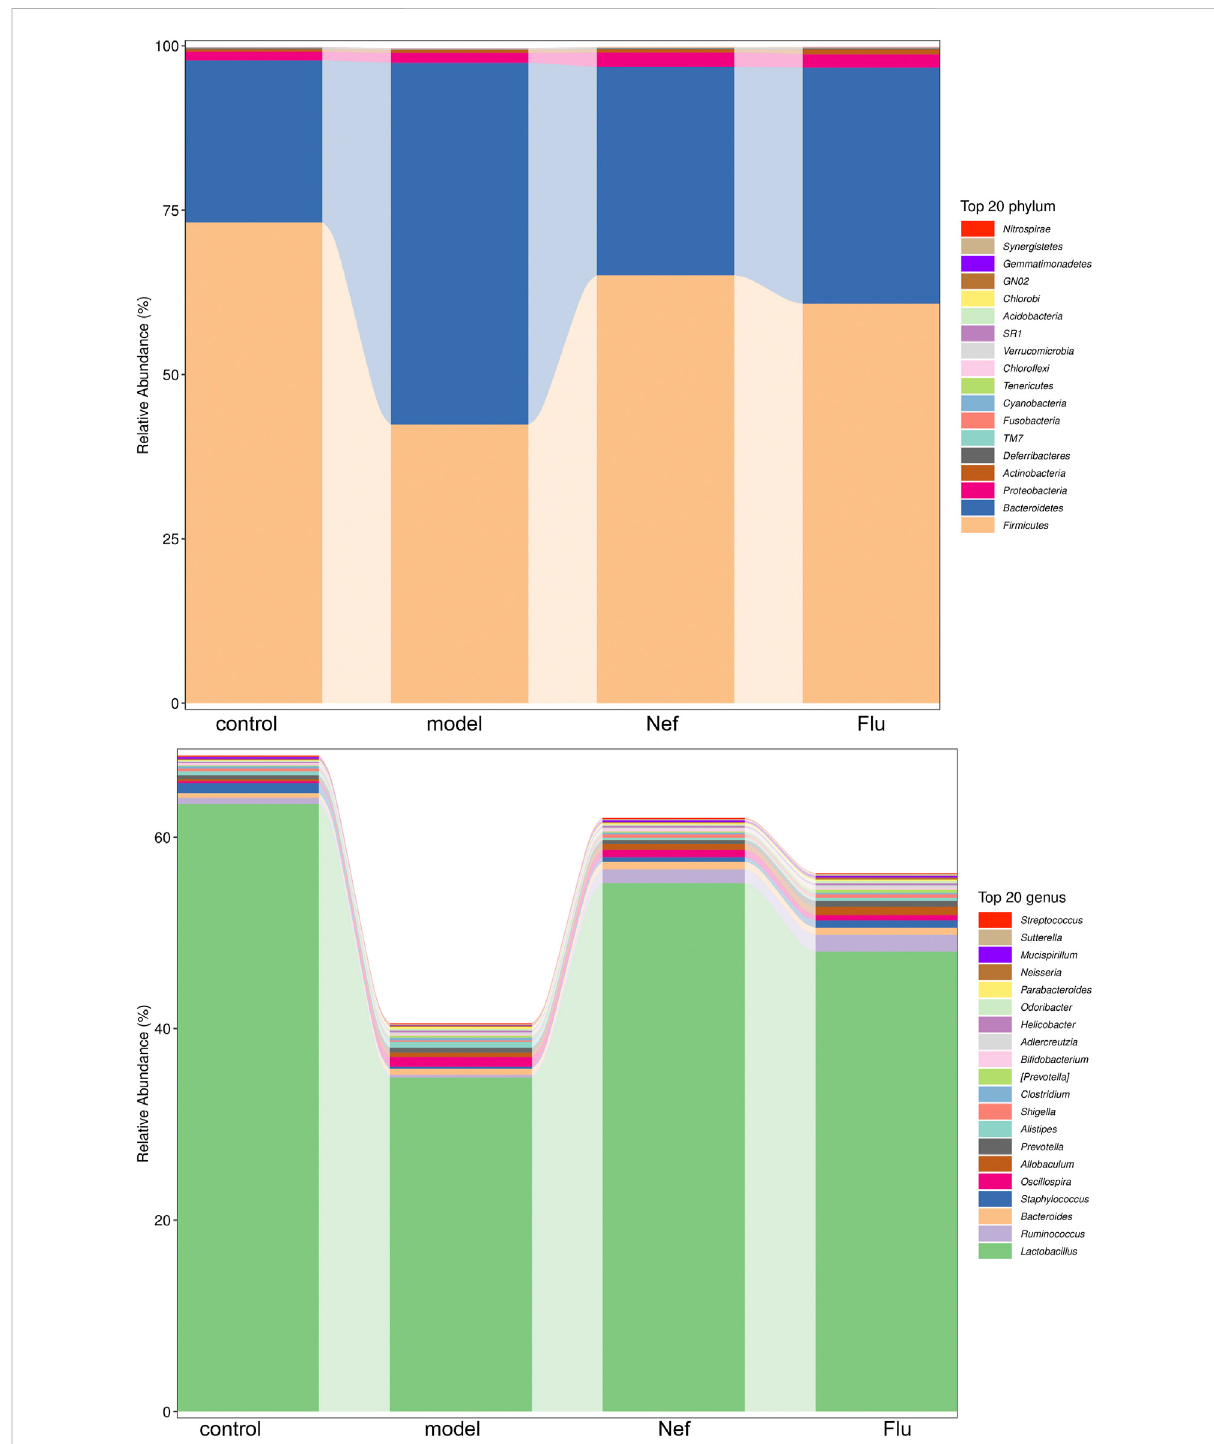
Nef treatment improves gut microbiota in depressed mice. The fi gure depicts gut microbiota composition in mice at phylum and genus levels ( n = 5 per group). Nef, neferine; Flu, fl uoxetine. At the phylum level, both Nef and Flu treatments reverted the changes in the relative abundances of Firmicutes and Bacteroidetes in the depressed mice. At the genus level, Nef as well as Flu treatments also restored the relative abundance of Lactobacillus in depressed